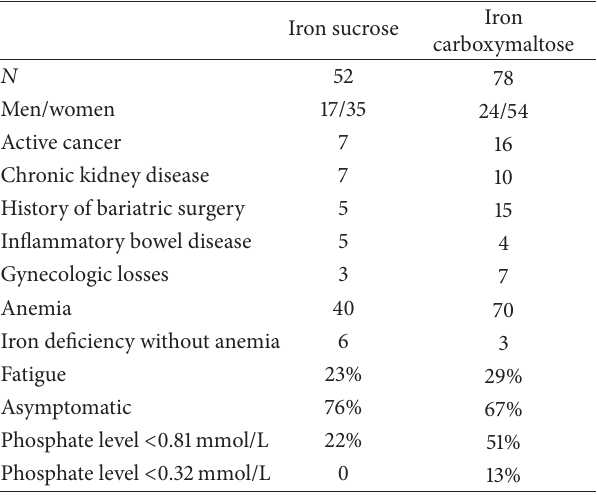
Table 1: Patient